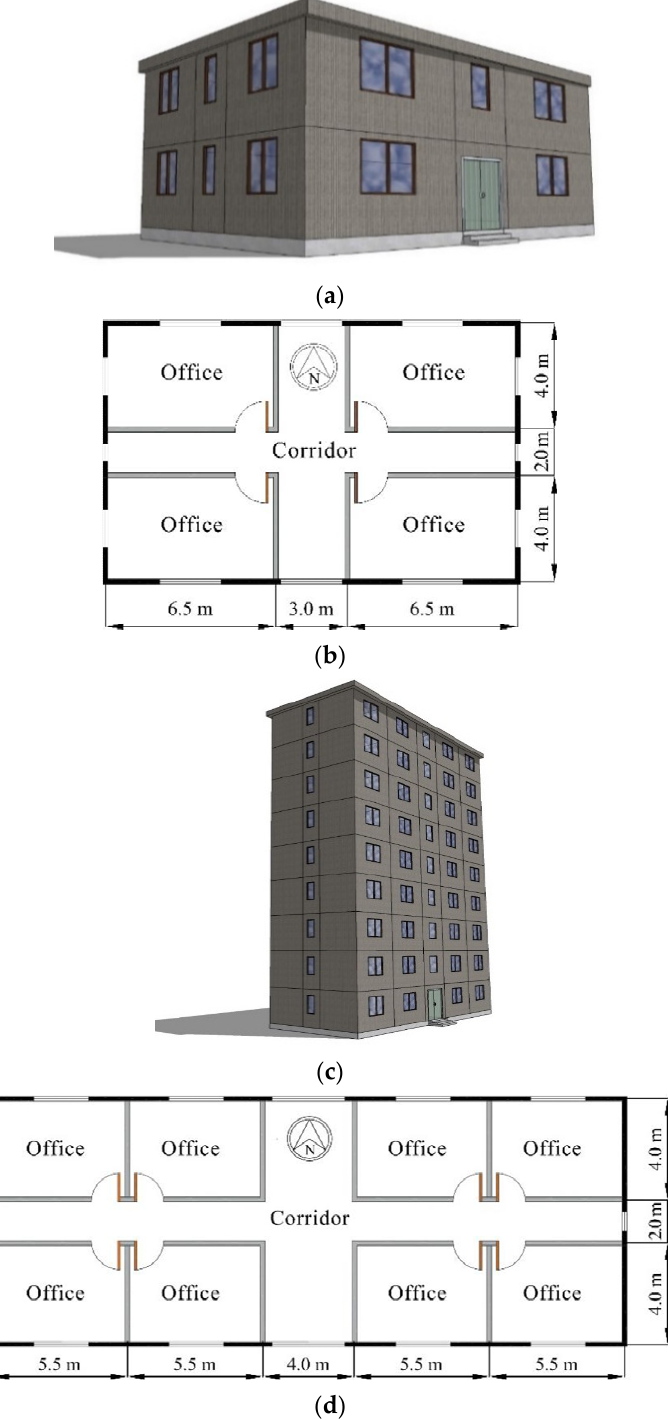
Figure 3. Building models and floor plans for the selected office buildings: ( a ) Building model with φ = 0.49; ( b ) Floor plan with φ = 0.49; ( c ) Building model with φ = 0.29; ( d ) Floor plan with φ = 0.29.